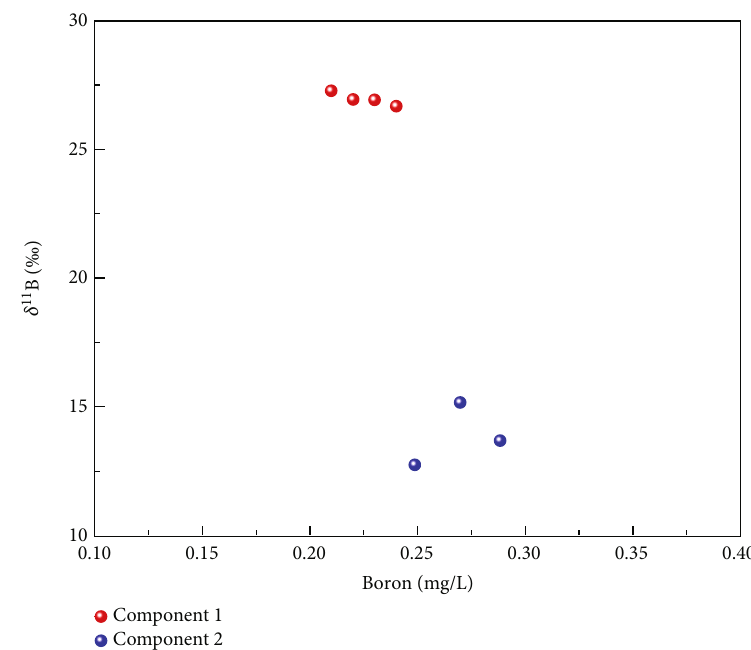
Figure 7: The relationship between boron isotopic composition and boron content in components 1 and